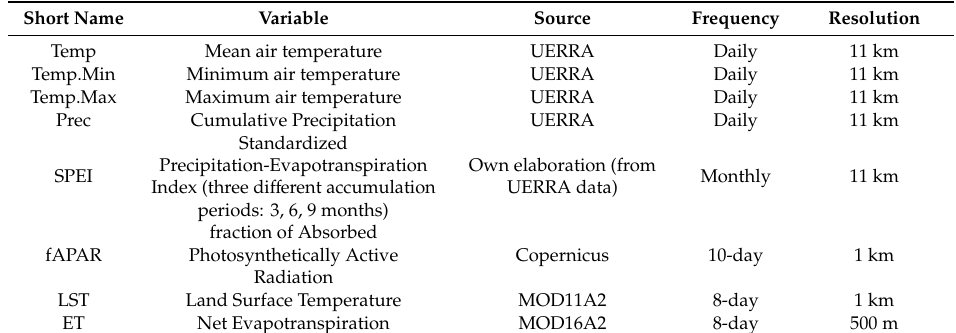
Table 2. Data sources and description of the weather and satellite-based indicators used in the construction of the analyzed statistical